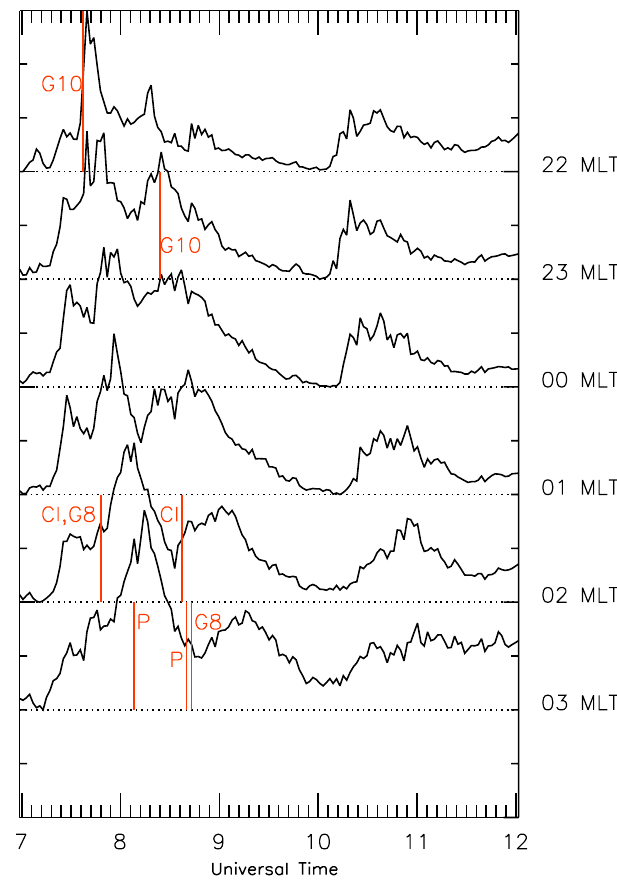
Fig. 10. Stack plot of auroral luminosity measured by FUV WIC on board the IMAGE spacecraft averaged over 1h of MLT and between 55 to 80° magnetic latitude. Each trace has had its minimum value subtracted, such that the dotted lines indicate the minimum value which has been set to 0R. The traces are separated by 1500R. The red lines indicate the times at which dipolarizations were detected by the Cluster (Cl), GOES (G8 or G10) or Polar (P) spacecraft, indicated in the appropriate MLT